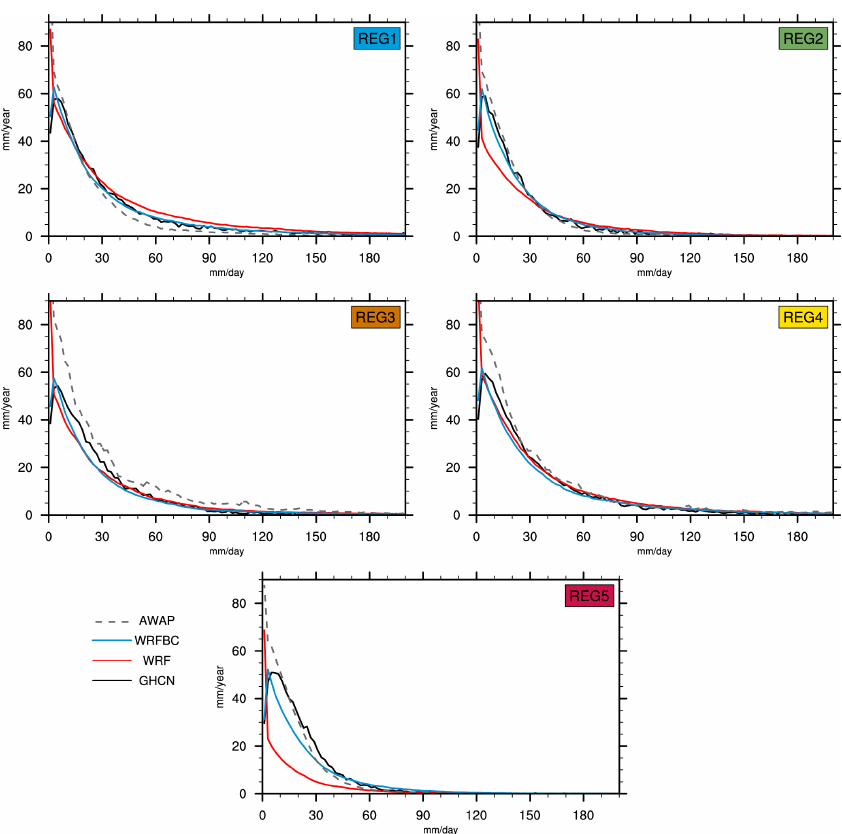
Fig. 7. Contribution to total annual precipitation by rainfall events of different intensity in the 5 preciptiation regions for AWAP, bias-corrected and non-corrected WRF outputs, and GHCN stations. 25